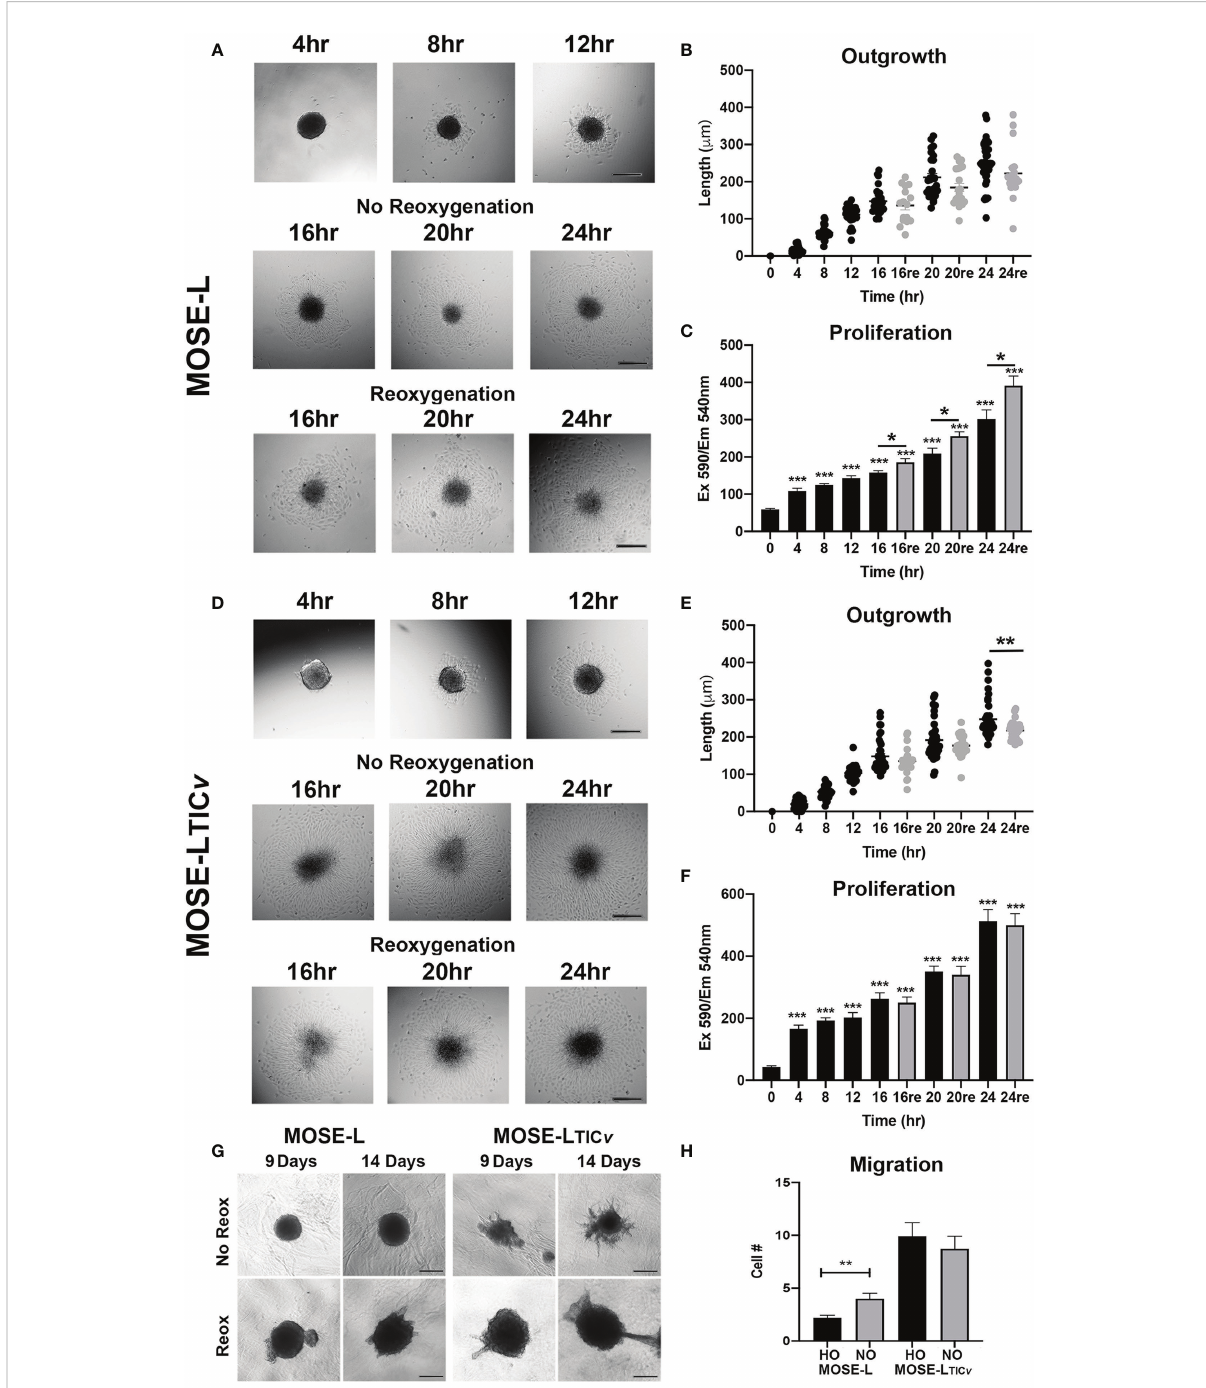
FIGURE 1 Adhesion and reoxygenation (reox) promote proliferation, invasion and migration. MOSE-L (A – C) and MOSE-L TIC v (D – F) spheroids adhered to culture plates in non-reoxygenated conditions and were switched to reoxygenated (re) conditions after 12 h. (G) Spheroid invasion into collagen gels after 9 and 14 days; (H) Boyden chamber analysis of cellular migration in normoxic (NO) and hypoxic (HO) conditions. Different from control at *p<0.05, **p<0.01, ***p<0.001. Scale bar set at